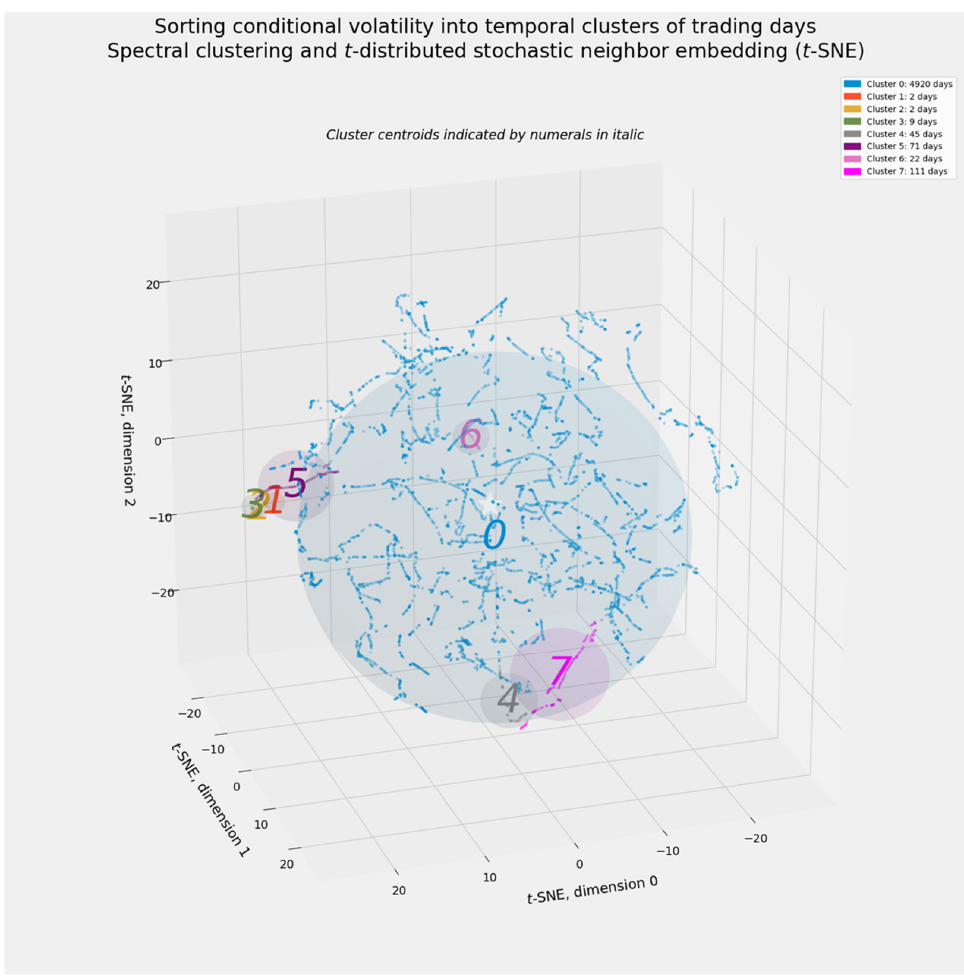
Figure 6. Spectral clustering of commodity markets—A t -SNE ( t -distriubted stochastic neighbor embedding) manifold.